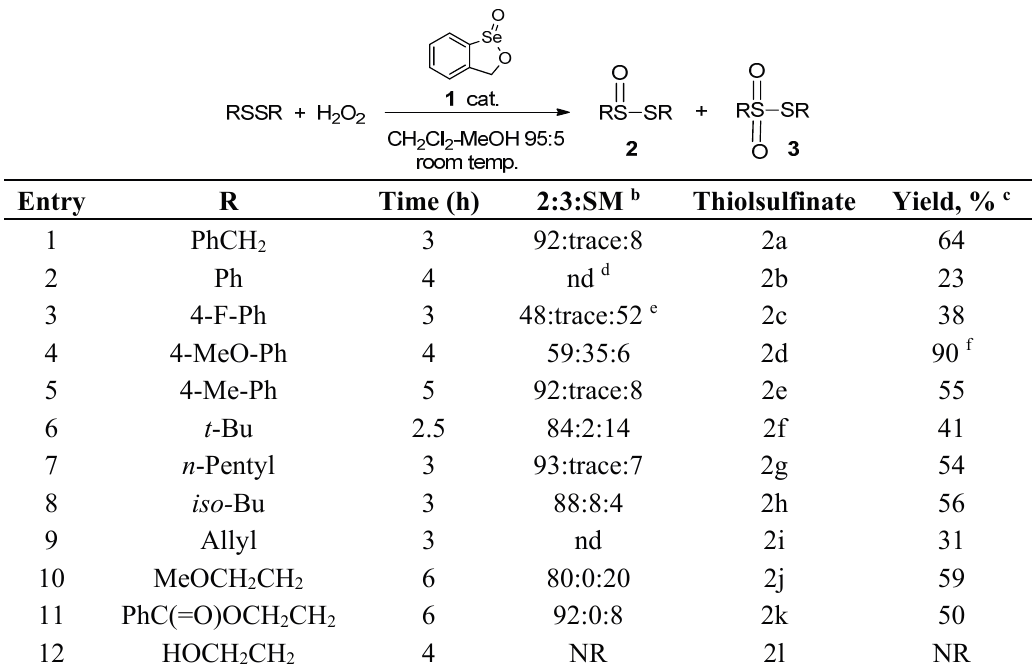
Table 2. Oxidation of symmetrical disulfides to thiolsulfinates 2 a